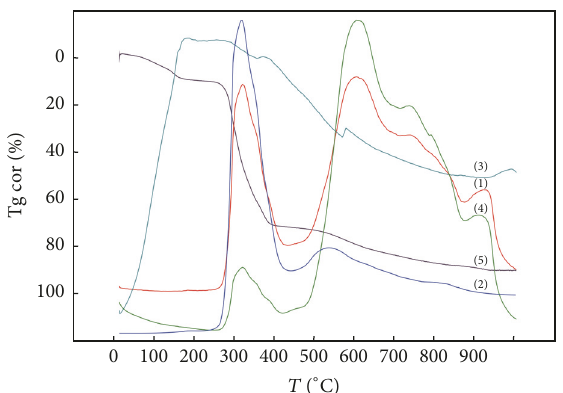
Figure 4: TG and corresponding MS analysis of Co(mef) 2 ⋅ 2H 2 O (where: (1) m/z = 12; (2) m/z = 15; (3) m/z = 18; (4) m/z = 44; (5) TG).